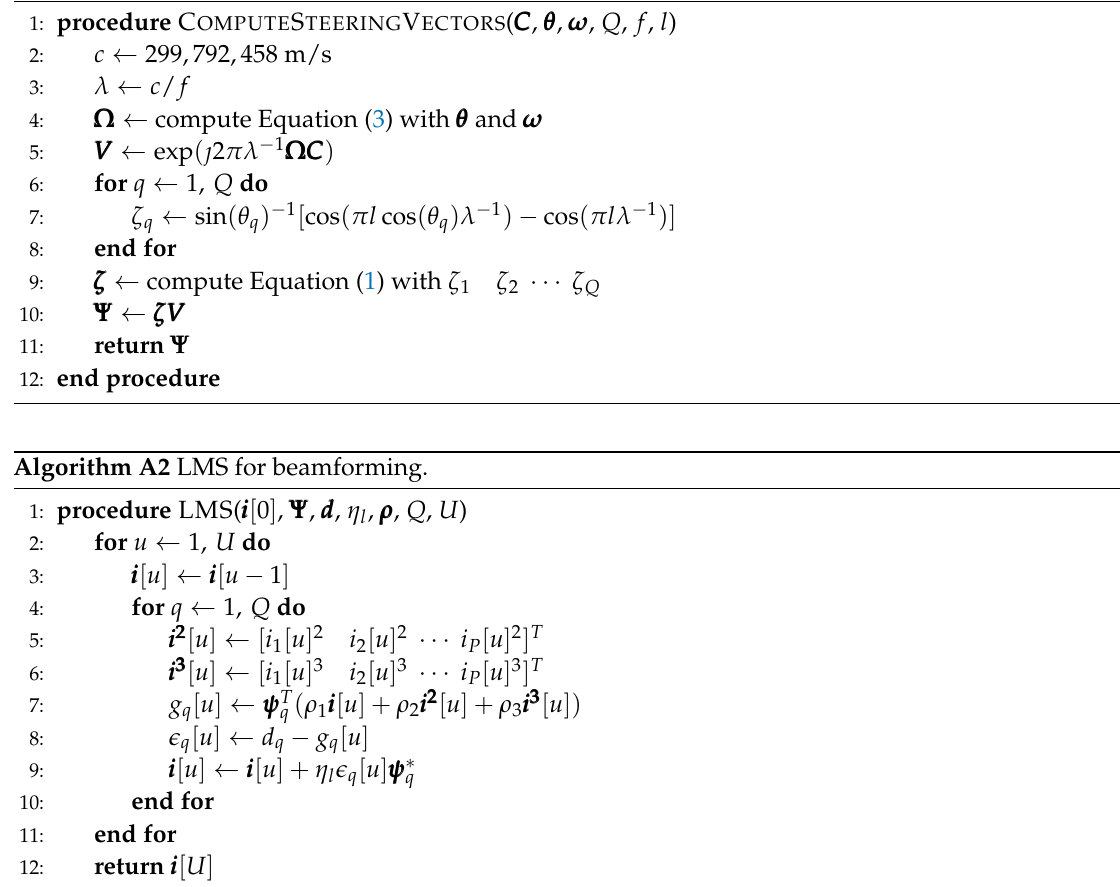
Algorithm A1 Steering vectors computation.